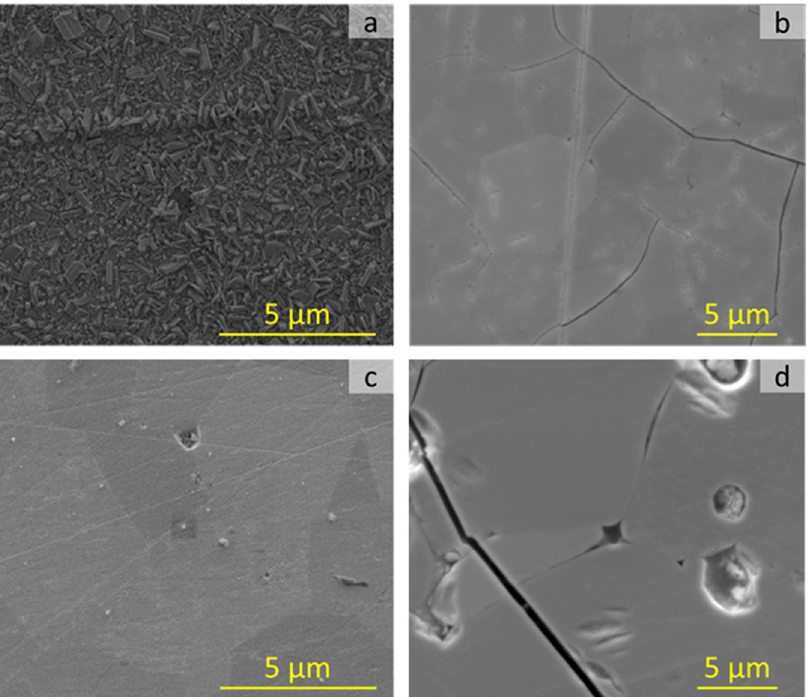
Fig. 5 SEM observations of homogeneous materials after alteration. Polished sintered pellets of homogeneous materials SEM images (SE mode) after leaching in 0.20 mmol.L − 1 H 2 O 2 solution: a UO 2 ; b U 0.92 Ce 0.08 O 2 ; c U 0.88 Ce 0.12 O 2 ; d U 0.75 Ce 0.25 O 2